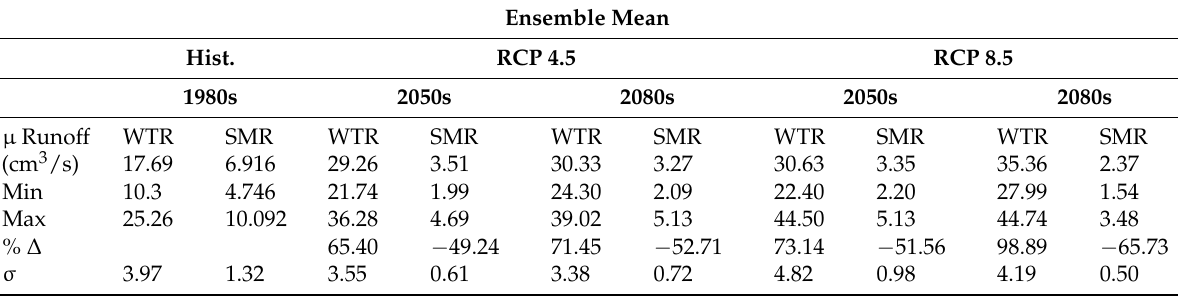
Table 5. Ensemble mean seasonal flows before forest cover reduction in the 1980s, 2050s, and 2080s. Ensemble Mean Hist. RCP 4.5 RCP